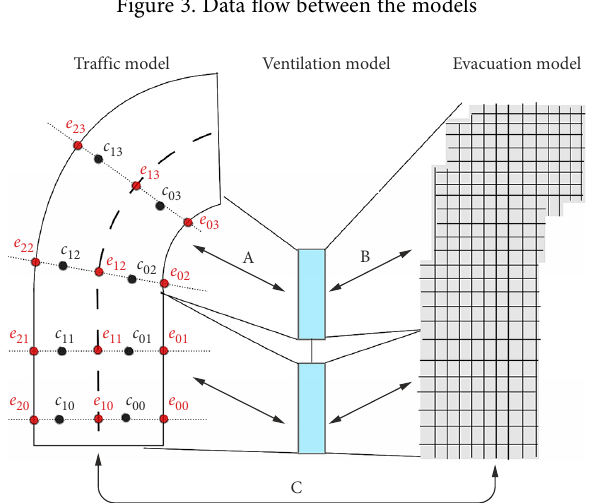
Figure 3. Data flow between the models